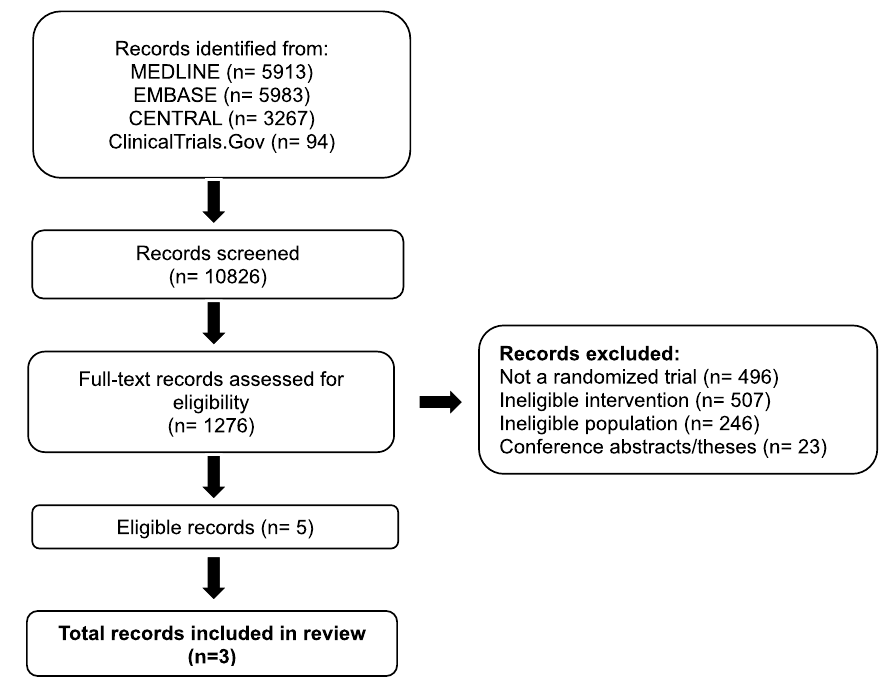
Fig. 2 Selection of studies for the systematic review. Our search yielded a total of 10,826 unique records. After title and abstract screening 1,276 records proved potentially eligible and after full‑text review 5 records proved eligible. We excluded records if they did not describe full‑text peer‑reviewed reports of randomized trials that compared amitriptyline with placebo for prophylaxis of migraine in adult